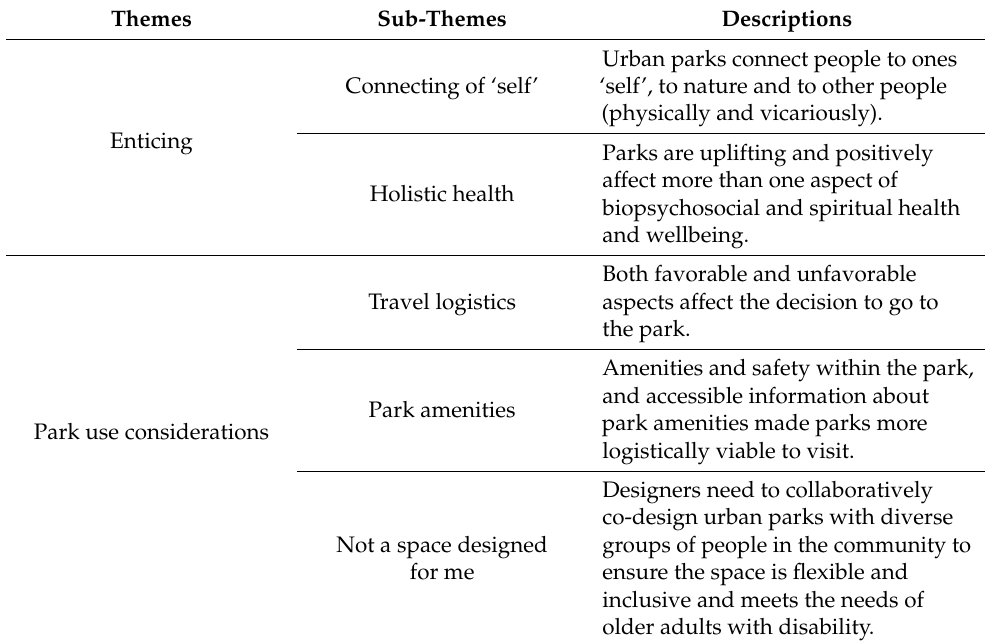
Table 3. Themes constructed from interviews with people living with disability about urban park use and